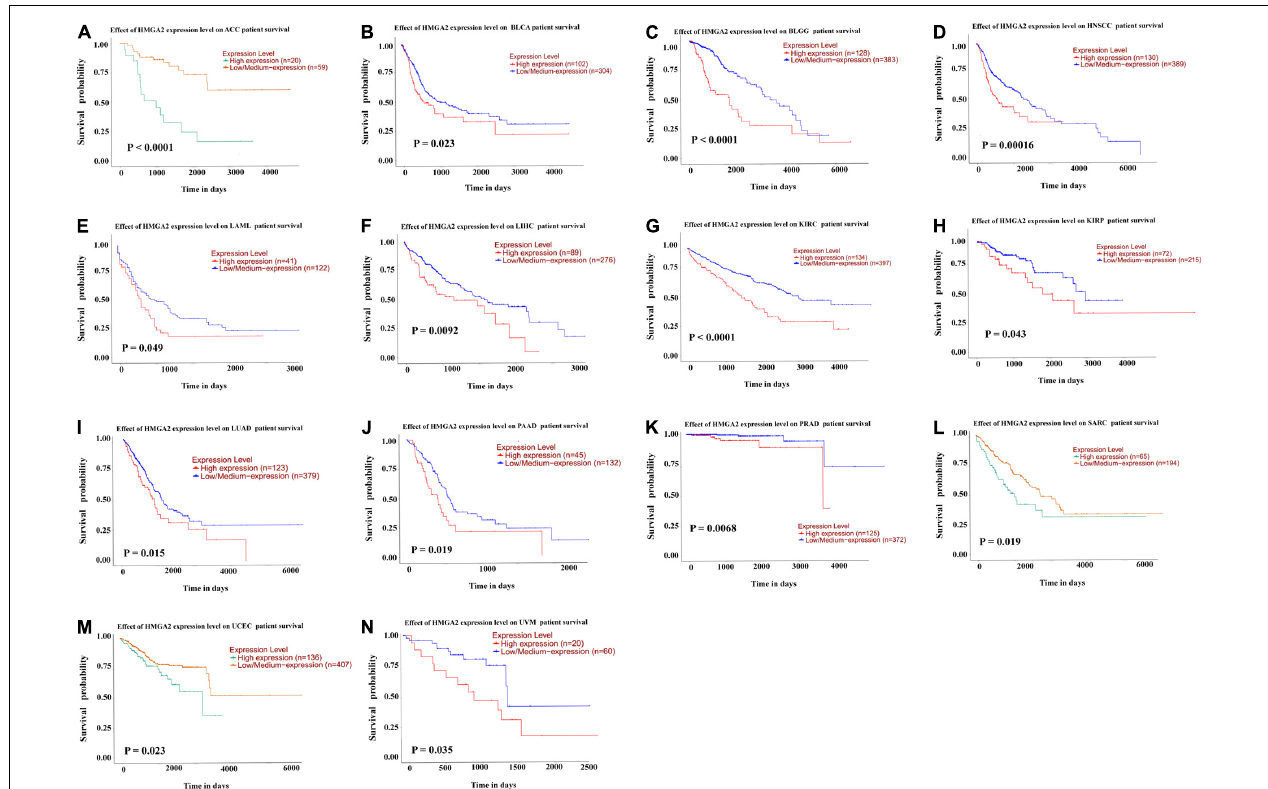
FIGURE 6 | Kaplan–Meier survival curves for cancer patients based on TCGA datasets. (A) adrenocortical carcinoma. (B) bladder urothelial carcinoma. (C) brain lower grade glioma. (D) head and neck squamous cell carcinoma. (E) kidney renal clear cell carcinoma. (F) kidney renal papillary cell carcinoma. (G) acute myeloid leukemia. (H) liver hepatocellular carcinoma. (I) lung adenocarcinoma. (J) pancreatic adenocarcinoma. (K) prostate adenocarcinoma. (L) sarcoma. (M) uterine corpus endometrial carcinoma. (N) uveal